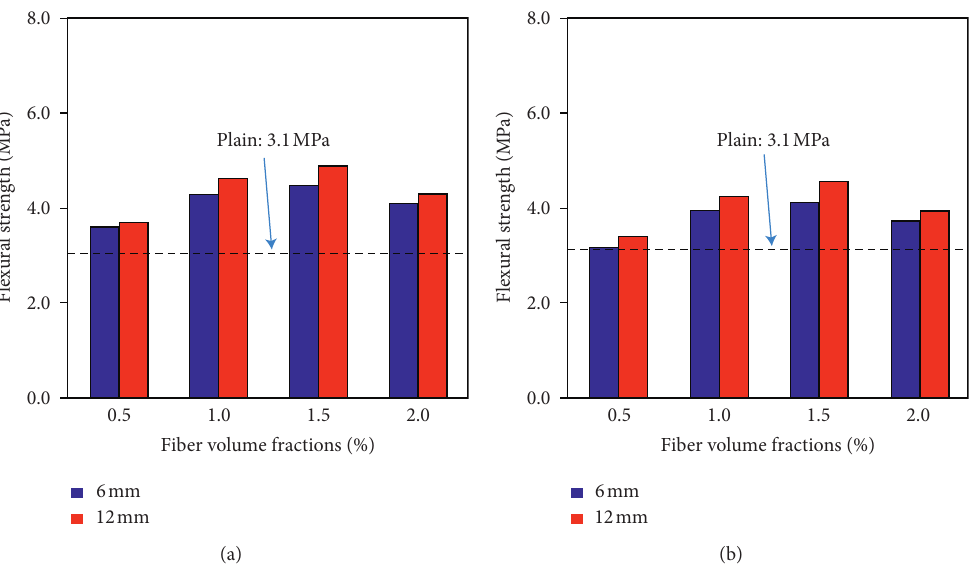
Figure 10: Relationships between flexural strengths of CFRM composite specimens with different fiber lengths and fiber volume fractions: (a) SiO 2 -coated carbon fiber and (b) uncoated carbon